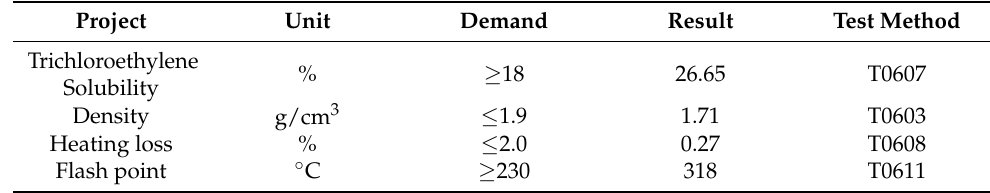
Table 3. Technical indexes of rock asphalt.